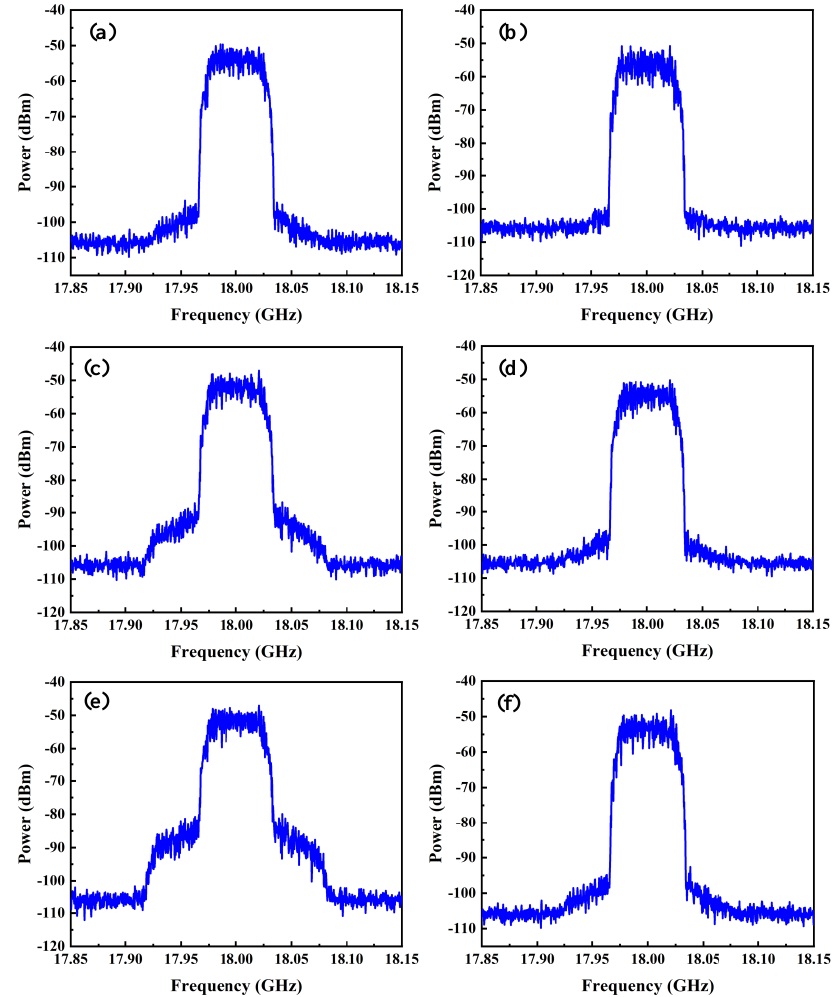
Figure 6. ( a , c , e ) The measured electrical spectra of traditional frequency up-conversion link based on traditional CS-DSB modulation; ( b , d , f ) the measured electrical spectra of the proposed system. The IF signal is 50-Mbaud 16-QAM with a center frequency of 2 GHz and power of 12 dBm, 15 dBm and 18 dBm accordingly (RBW = 3 MHz) .